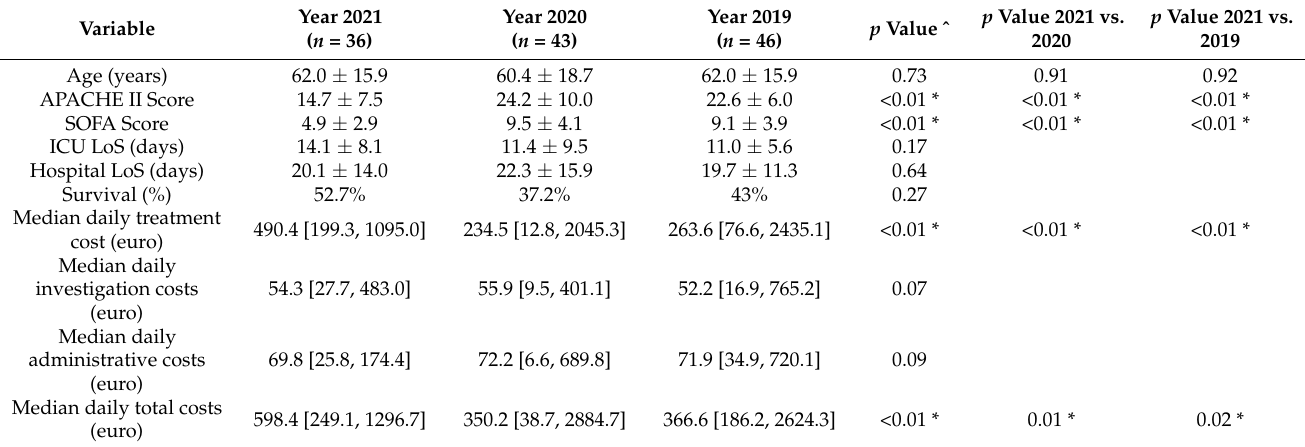
Table 1. Comparison of demographic data and mean daily costs among the three time